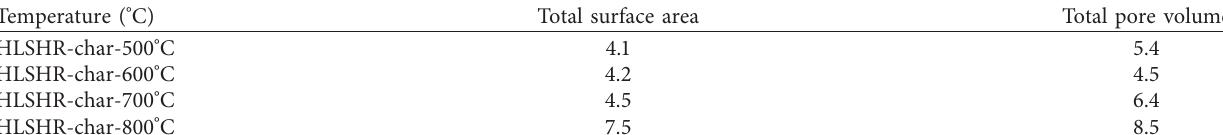
Table 5: Total specific surface area and pore volume of copyrolysis